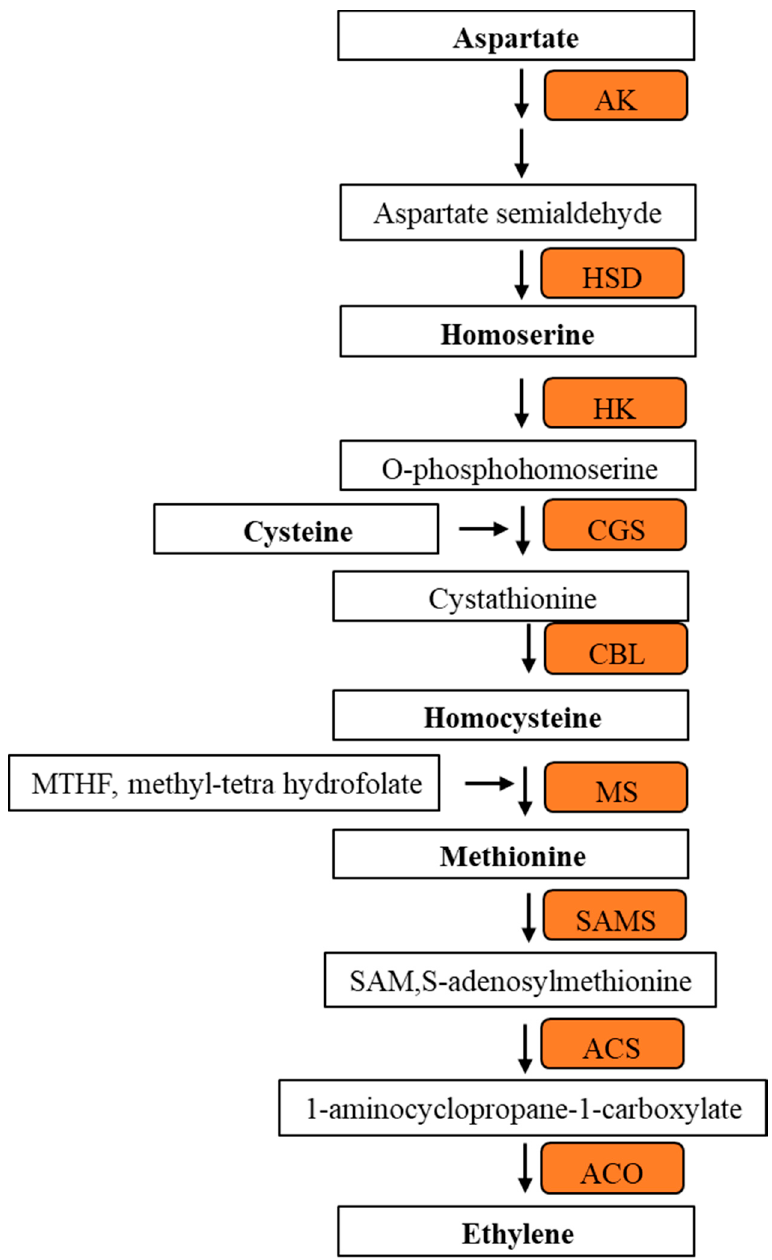
Figure 6. Metabolites of aspartate and additional precursors related to ethylene biosynthesis. The levels of metabolites in bold letters were measured during ripening. Abbreviations: AK, Aspartate kinase; HSD, homoserine dehydrogenase; HK, homoserine kinase; CGS, cystathionine-gamma-synthase; CBL, cystathionine-beta-lyase; MS, Methionine synthase; SAMS, S-adenosyl-methionine synthase; ACS, ACC synthase; ACO, ACC oxidase.